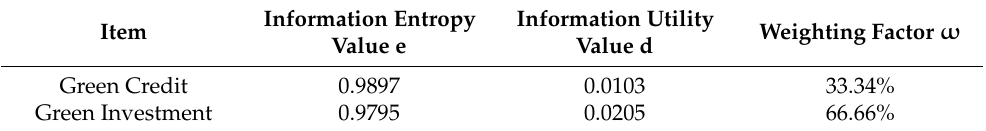
Table 1. Summary of the results of the entropy method for calculating weights.